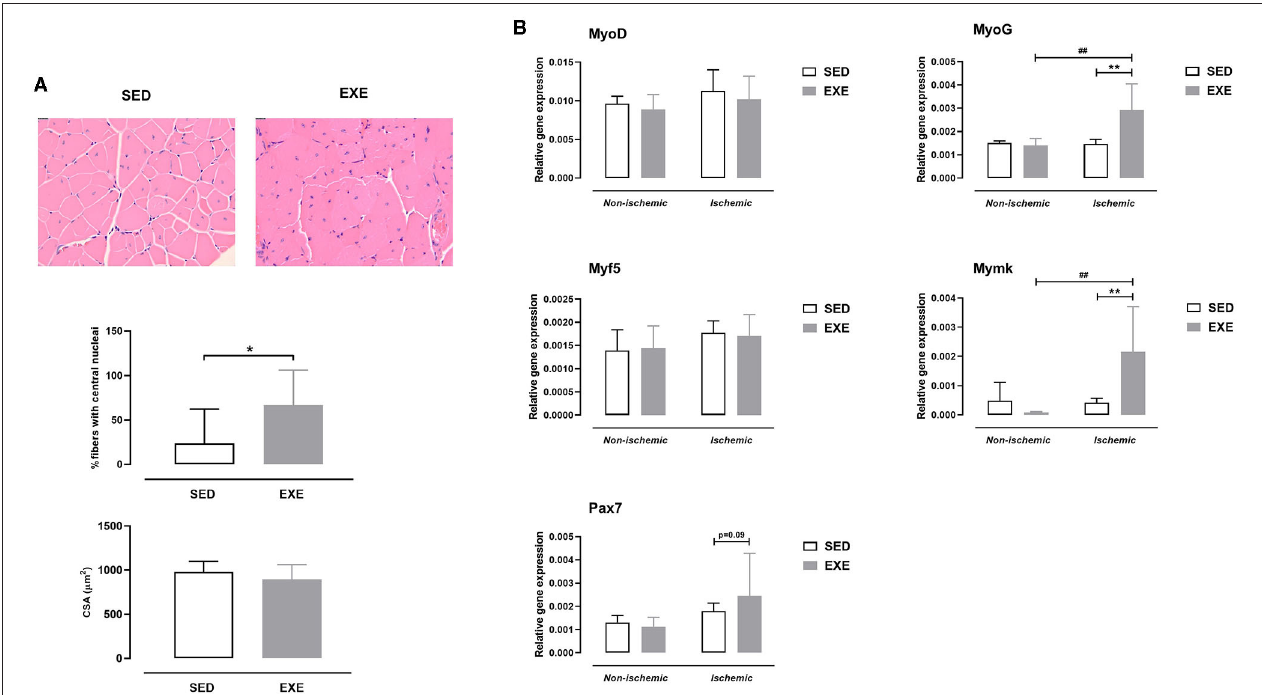
FIGURE 4 | Effect of preventive exercise on ischemic hindlimb muscle regeneration in ApoE − / − mice with PAD. (A) Top: Representative images of ischemic gastrocnemius cross-sections stained with H&E at × 20 high-power field. Middle: Quantification of centro-nucleated moyfibers at week 5 post-ischemia ( n = 7-10 animals per group). Bottom: Quantification of cross-sectional area (CSA) of regenerating ischemic gastrocnemius myofibers ( n = 3-9 animals per group). (B) Gene expression analysis by real-time RT-PCR of key genes involved in muscle regeneration (MyoD, MyoG, Myf5, Mymk, and Pax7) in non-ischemic and